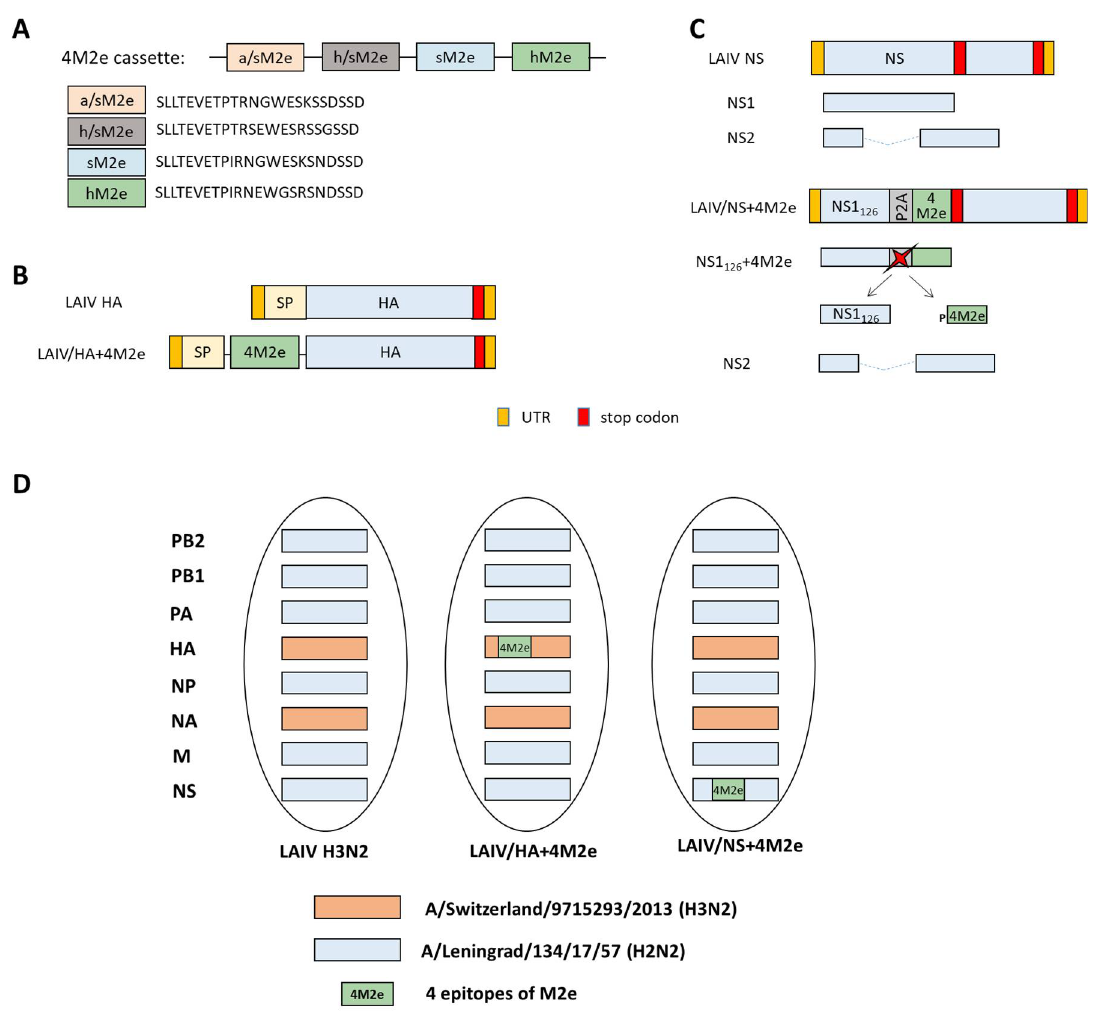
Figure 1. Overview of LAIV viruses used in this study. ( A ) Scheme of the 4M2e cassette. Flexible Gly-linkers were used to join the M2e epitopes. ( B ) Scheme of the chimeric HA gene containing the 4M2e cassette. ( C ) Scheme of the chimeric truncated NS1 gene containing the 4M2e cassette. ( D ) Genome composition of the LAIV viruses used in this study. hM2e: human M2e lineage; sM2e: swine M2e lineage; a/sM2e: avian/swine M2e lineage; h/sM2e: human/swine M2e lineage, as described in [5] . 2A: porcine teschovirus-1 P2A self-cleavage site (GSGATNFSLLKQAGDVEENPG ↓ P).